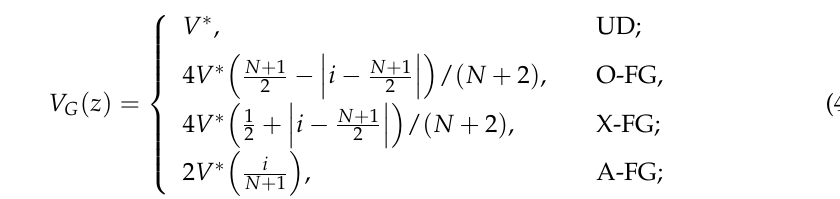
(cid:112) ρ m / E m of FG GPLs-reinforced